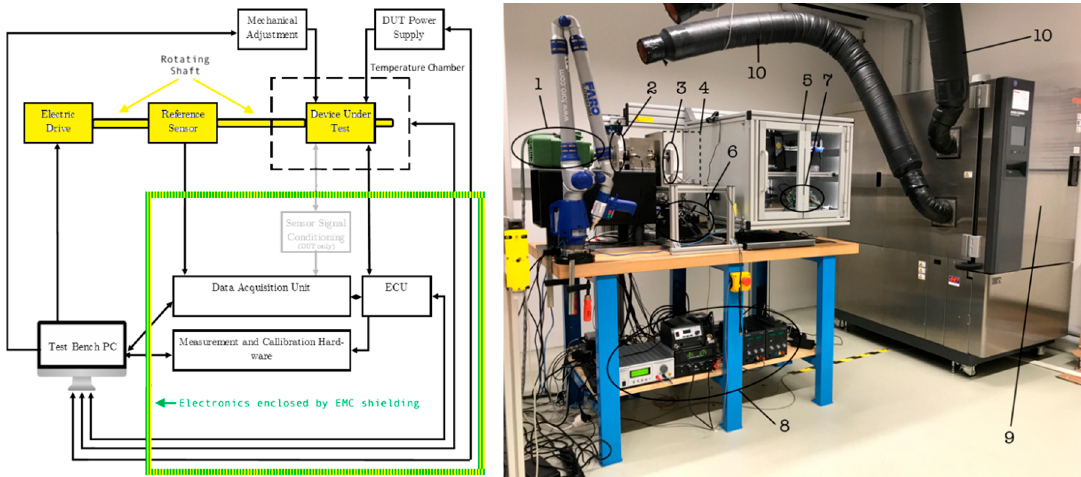
Figure 2. ( left ): sensor test bench system overview; ( right ): sensor test bench and relevant components: 1: electric drive; 2: reference sensor; 3: device under test (DUT, resolver); 4: specific temperature chamber (removed for demonstration ‐ see dashed box); 5: data acquisition housing (incl. electromagnetic compatibility (EMC) shielding); 6: motorized positioning actuators; 7: electronic control unit (ECU); 8: controlled and fixed power supply; 9: climatic chamber (temperature conditioning); 10: thermal tubes (for thermal transfer).